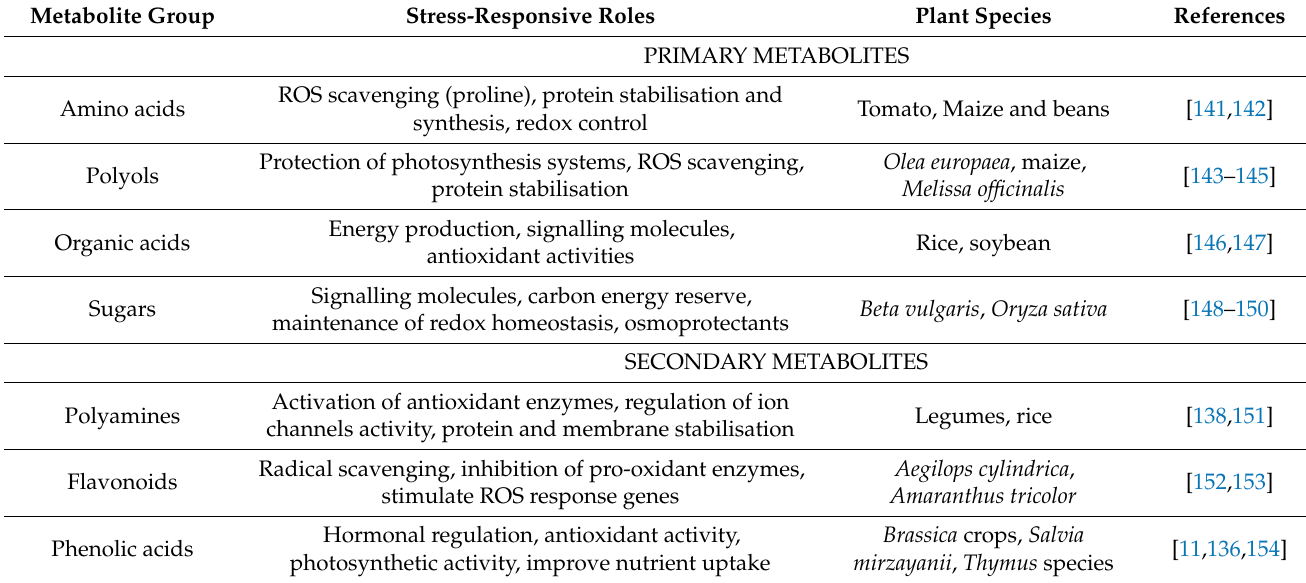
Table 2. An overview of metabolism alterations in response to osmotic stresses, and their corresponding roles in plant stress